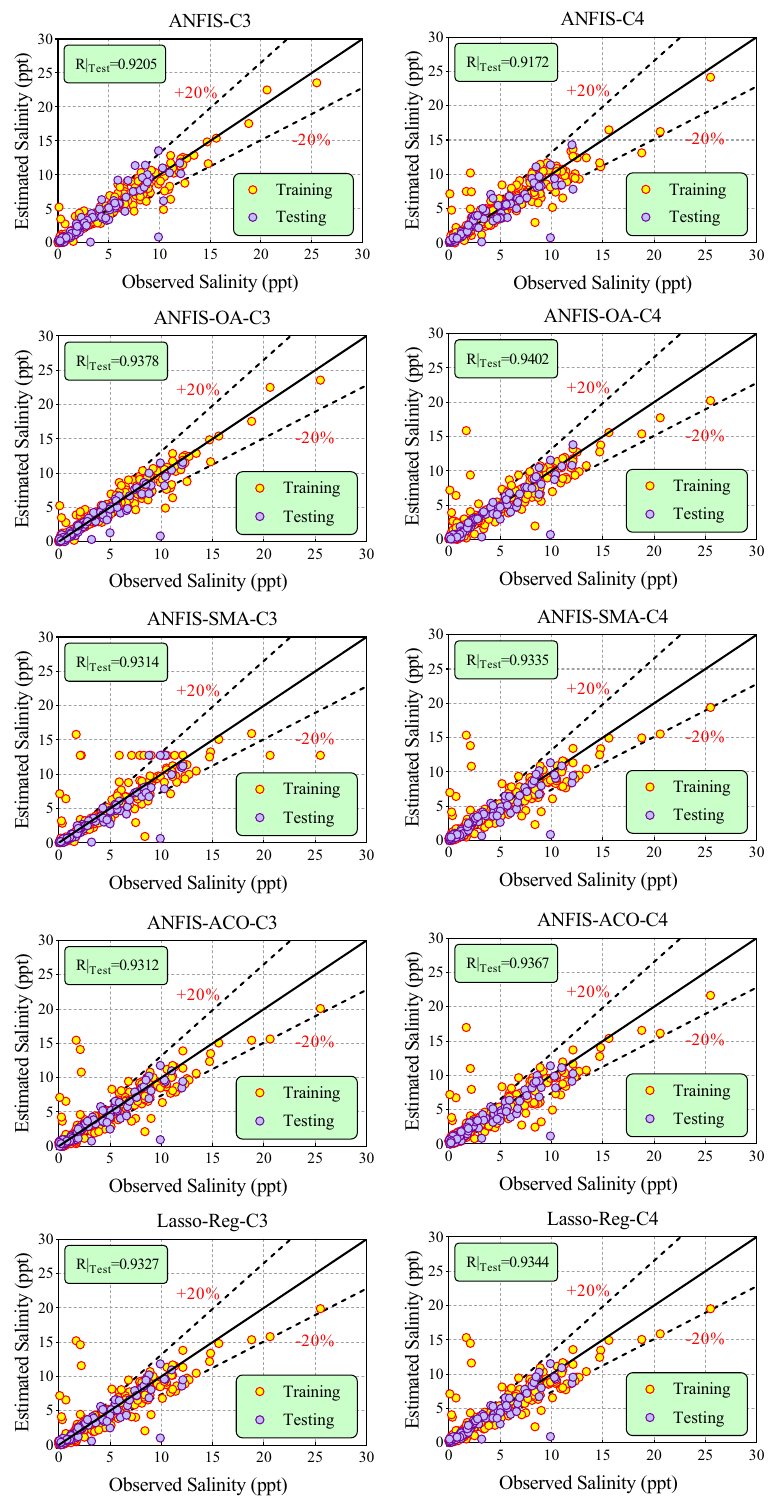
Figure 9. Continue; scatter plot of observational and predicted values of salinity of groundwater using the provided models in all the